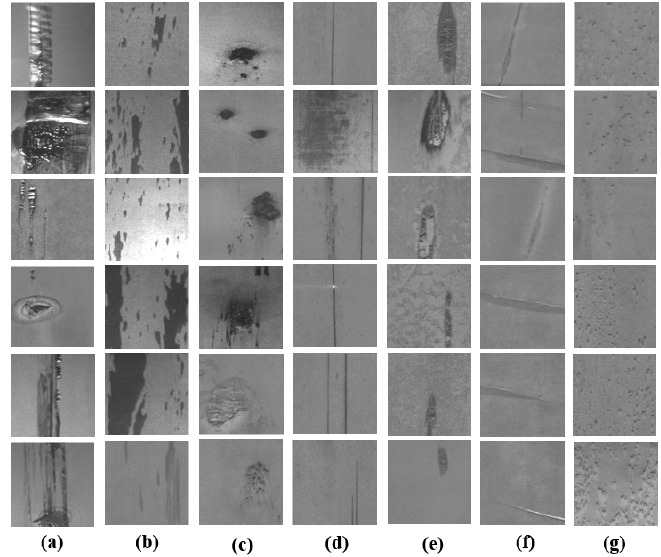
Figure 2. Examples for the seven kinds of defect classes of the Xsteel surface defect dataset (X- SSD) [1]: ( a ) inclusion (Si), ( b ) red iron sheet (Ri) , ( c ) iron sheet ash (Is), ( d ) scratches (Ss), ( e ) oxide scale-of-plate system (Op), ( f ) finishing roll printing (Fr), ( g ) oxide scale-of-temperature system